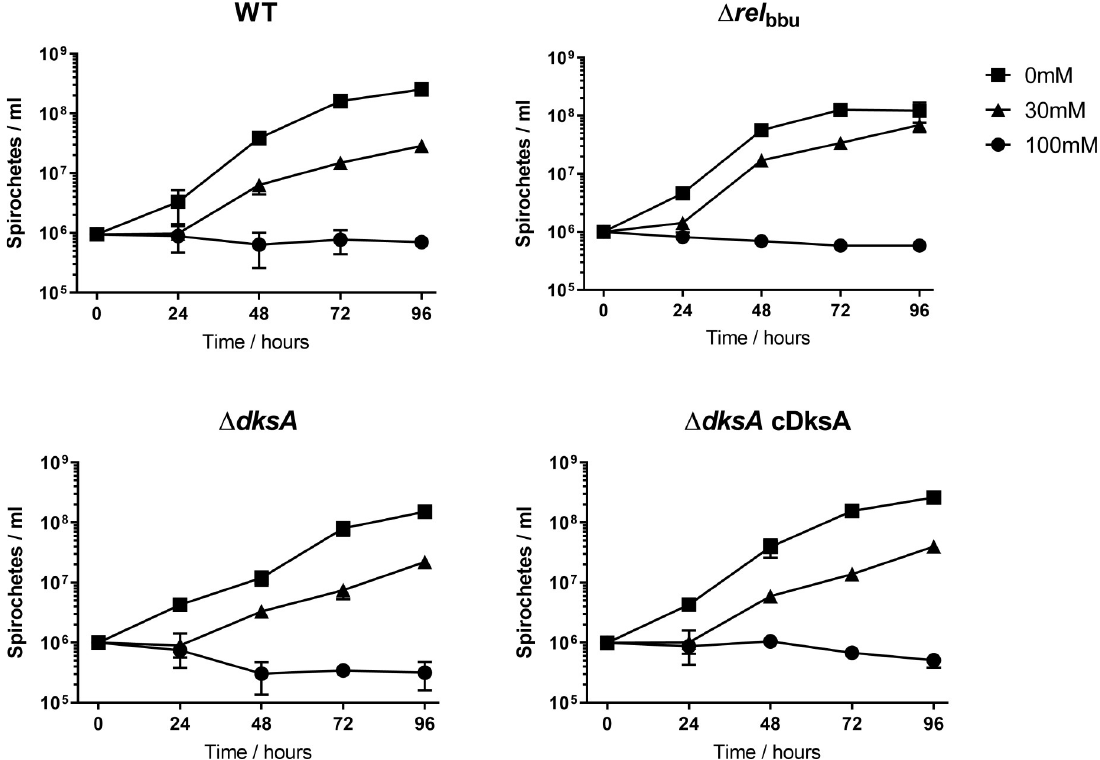
Fig 7. Growth rates of B . burgdorferi in acidic environment. B . burgdorferi 297 wild-type (WT), Δ rel Bbu , Δ dksA , and chromosomally complemented Δ dksA strain ( Δ dksA cDksA) were cultured in BSK II containing 0 mM acetate, pH 7.6 (square), 30 mM acetate, pH 6.1 (triangle), and 100 mM acetate, pH 4.6 (circle). Growth curves are representative of 3 replicate cultures and error bars represent standard deviation.